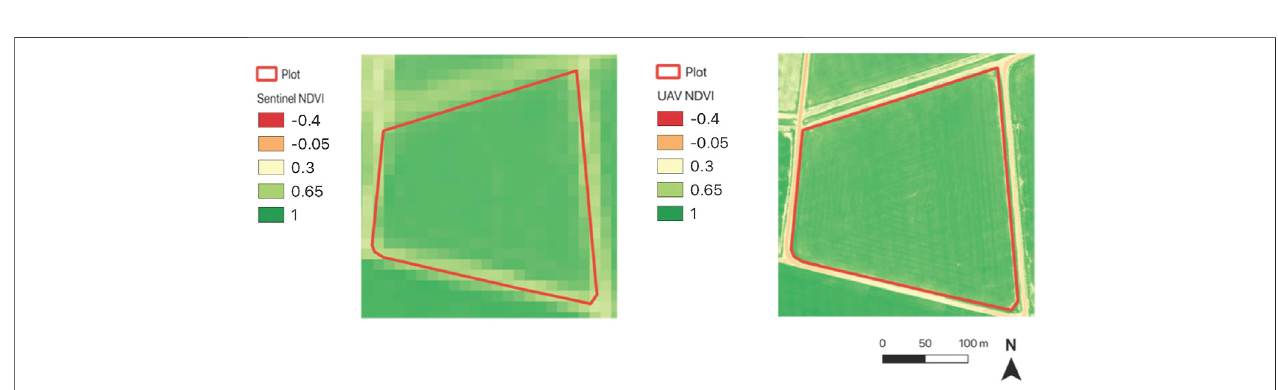
FIGURE 8 | NDVI maps calculated for rice plot 6 (Quinta do Canal) using data from Sentinel-2A (left) and UAS (right) imagery. The data were obtained during the rice reproductive phase, respectively, on the 8th and 9th of July, 2020.